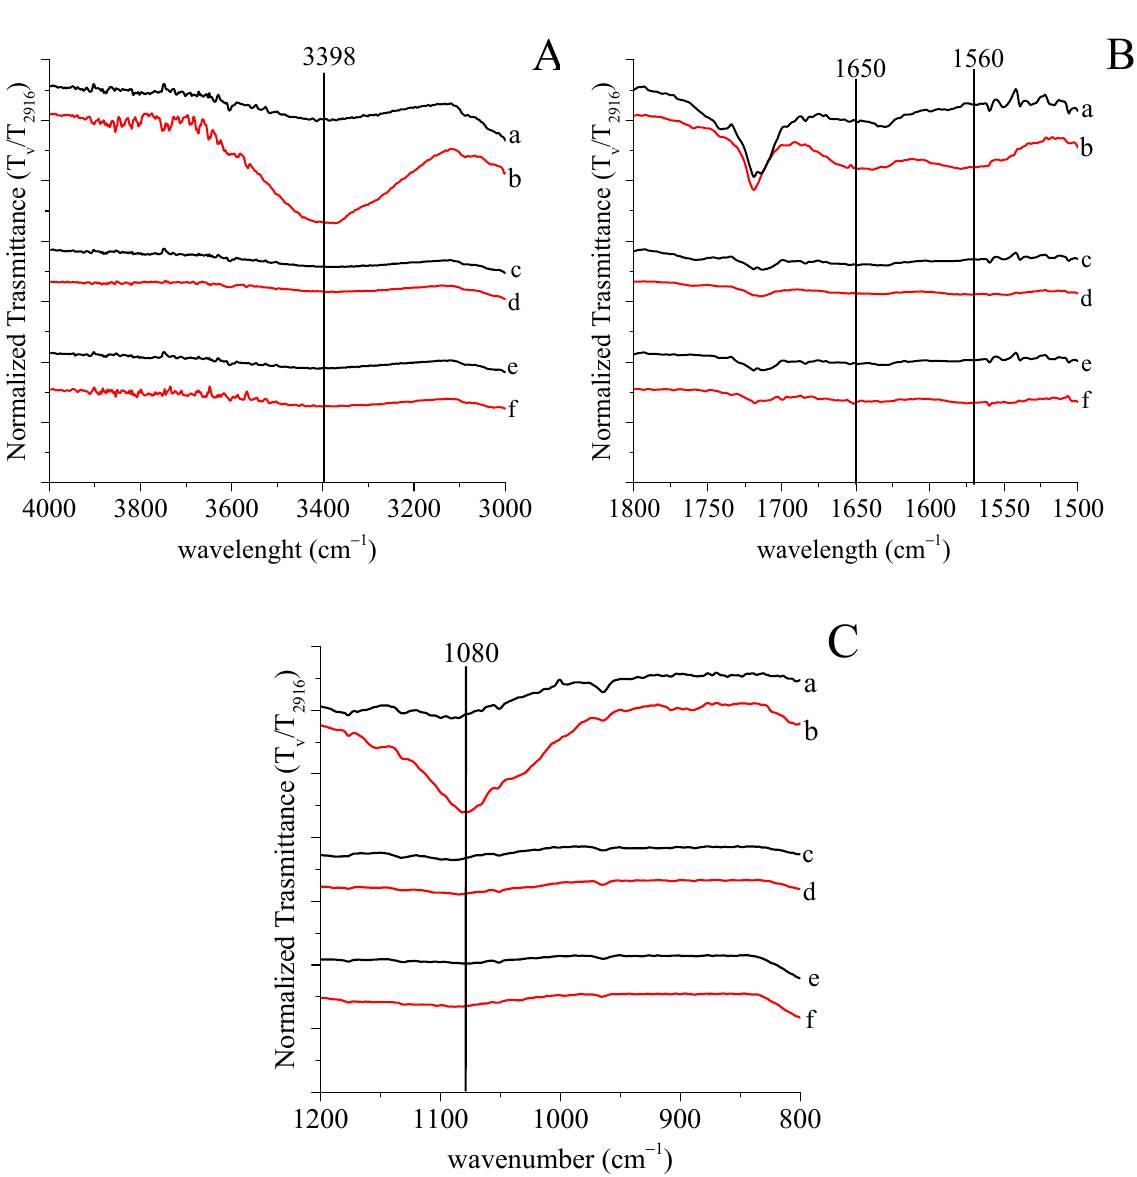
Figure 4. ( A – C ) ATR spectra in different regions of infrared absorption bands for HDPE/ATZ composites: ( a ) HDPE/ATZ Figure 4. ( A )–( C )ATR spectra in different regions of infrared absorption bands for HDPE/ATZ com- 99/1, ( c ) HDPE/ATZ 98/2, and ( e ) HDPE/ATZ 93/7 composites before grafting; ( b ) HDPE/ATZ 99/1, ( d ) HDPE/ATZ posites: ( a ) HDPE/ATZ 99/1, ( c ) HDPE/ATZ 98/2, and ( e ) HDPE/ATZ 93/7 composites before graft- 98/2, and ( f ) HDPE/ATZ 93/7 composites after 3 h of reaction. ing; ( b ) HDPE/ATZ 99/1, ( d ) HDPE/ATZ 98/2, and ( f ) HDPE/ATZ 93/7 composites after 3 h of reac- tion. Table 3. Contact angle value ( ◦ ) by sessile drop method for HDPE and HDPE/ATZ composites after